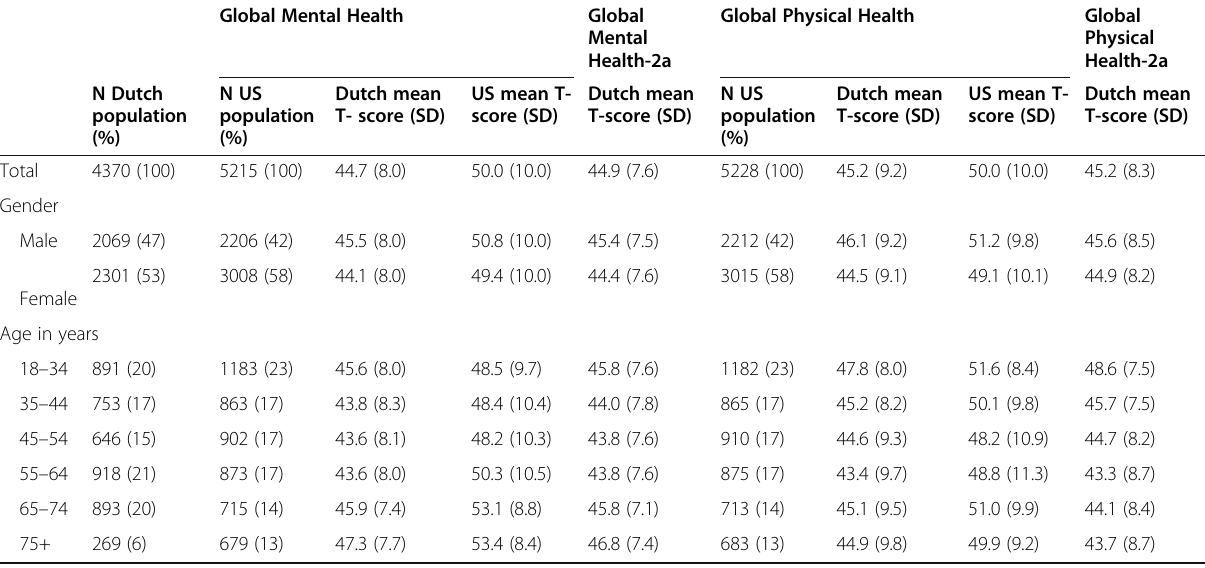
Table 3 PROMIS GMH and GPH reference values a for the Dutch general population by age and gender and comparisons with the